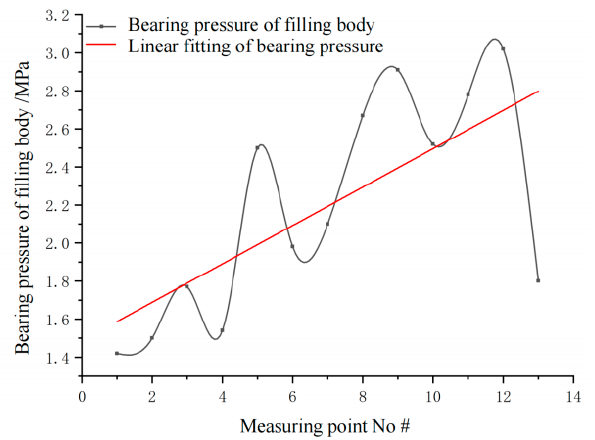
Figure 16. Pressure distribution characteristics on the support of the filling.